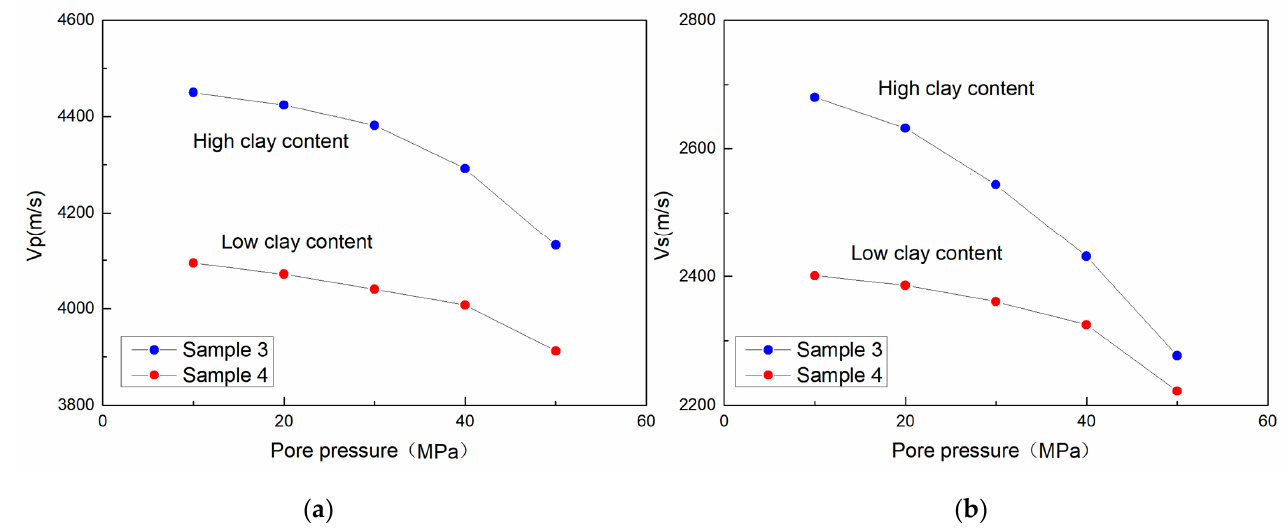
Figure 12. Cross-plot of pore pressure and ( a ) P- and ( b ) S-wave velocity.